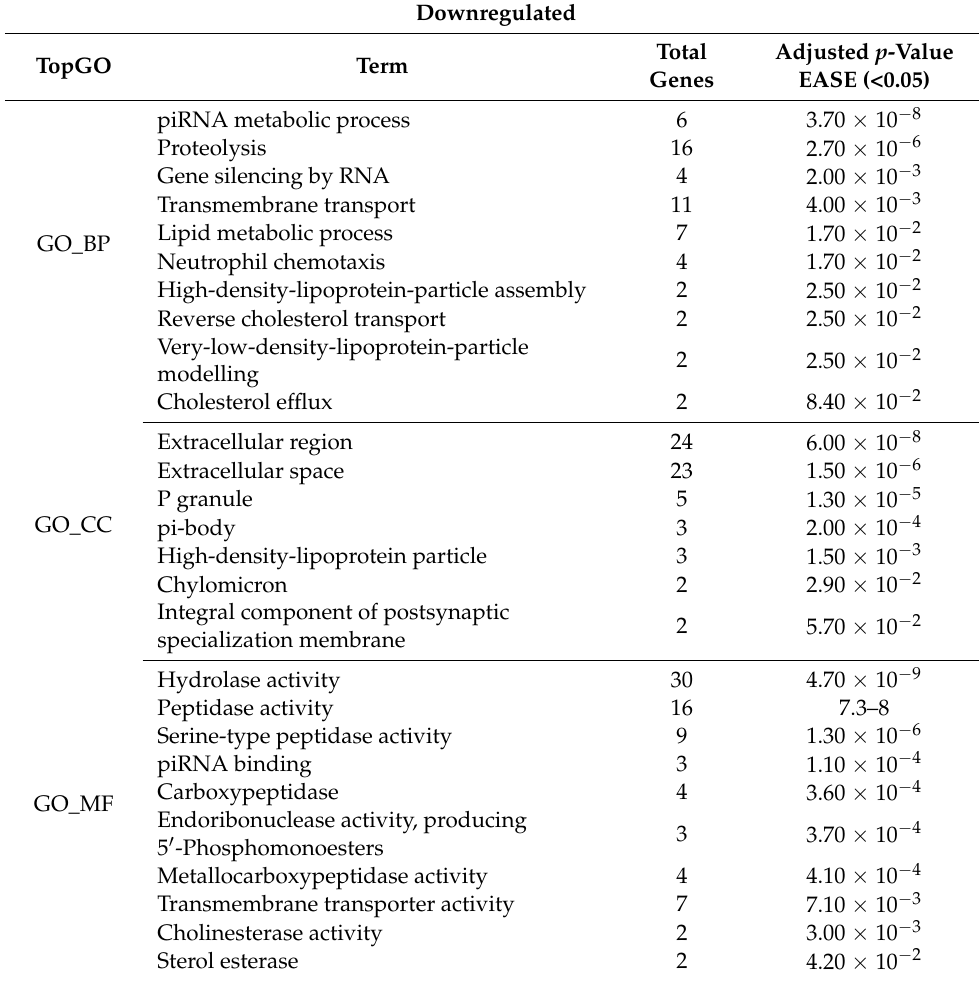
Table 2. Top 10 downregulated gene sets enriched based on gene ontology (GO) term with adjusted p -value EASE score.